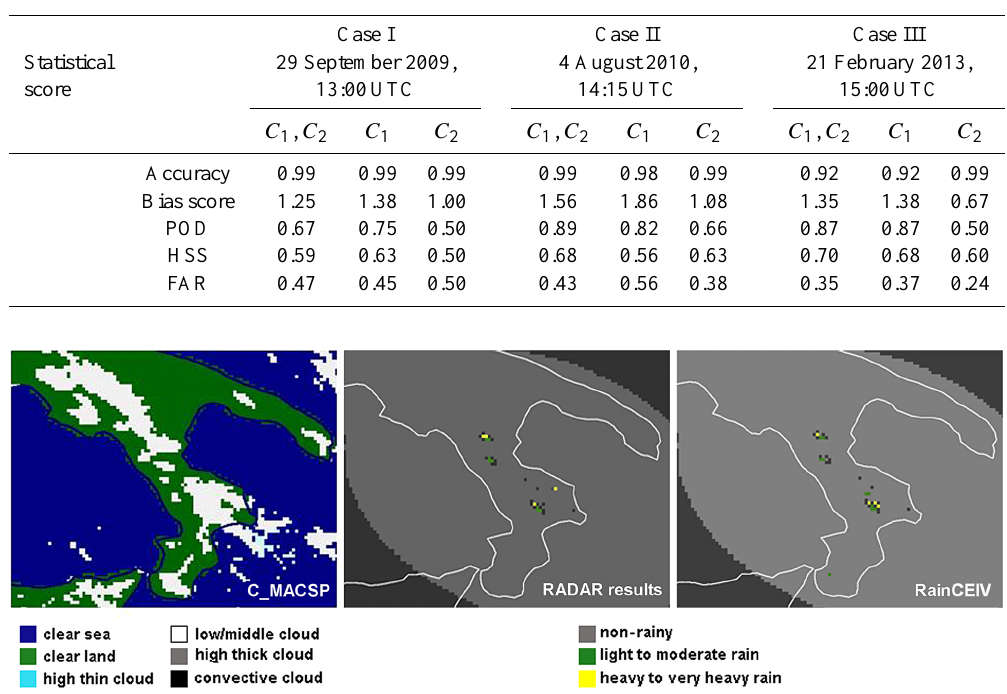
Table 12. Dichotomous statistical scores shown for all rainy classes ( C 1 , C 2 ) , light to moderate rain ( C 1 ) , and heavy to very heavy rain ( C 2 ) , for the case studies I, II and III.